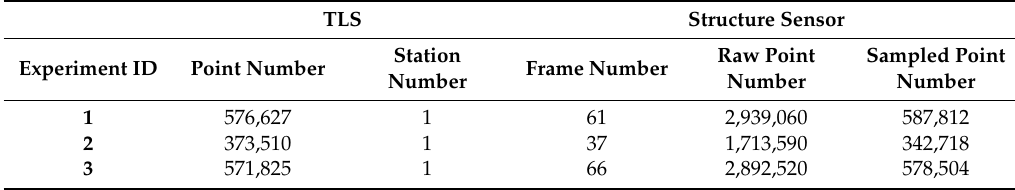
Table 5. Quantitative analysis of measured “narrow” walls. Table 6. Information about dataset generated by TLS and the Structure